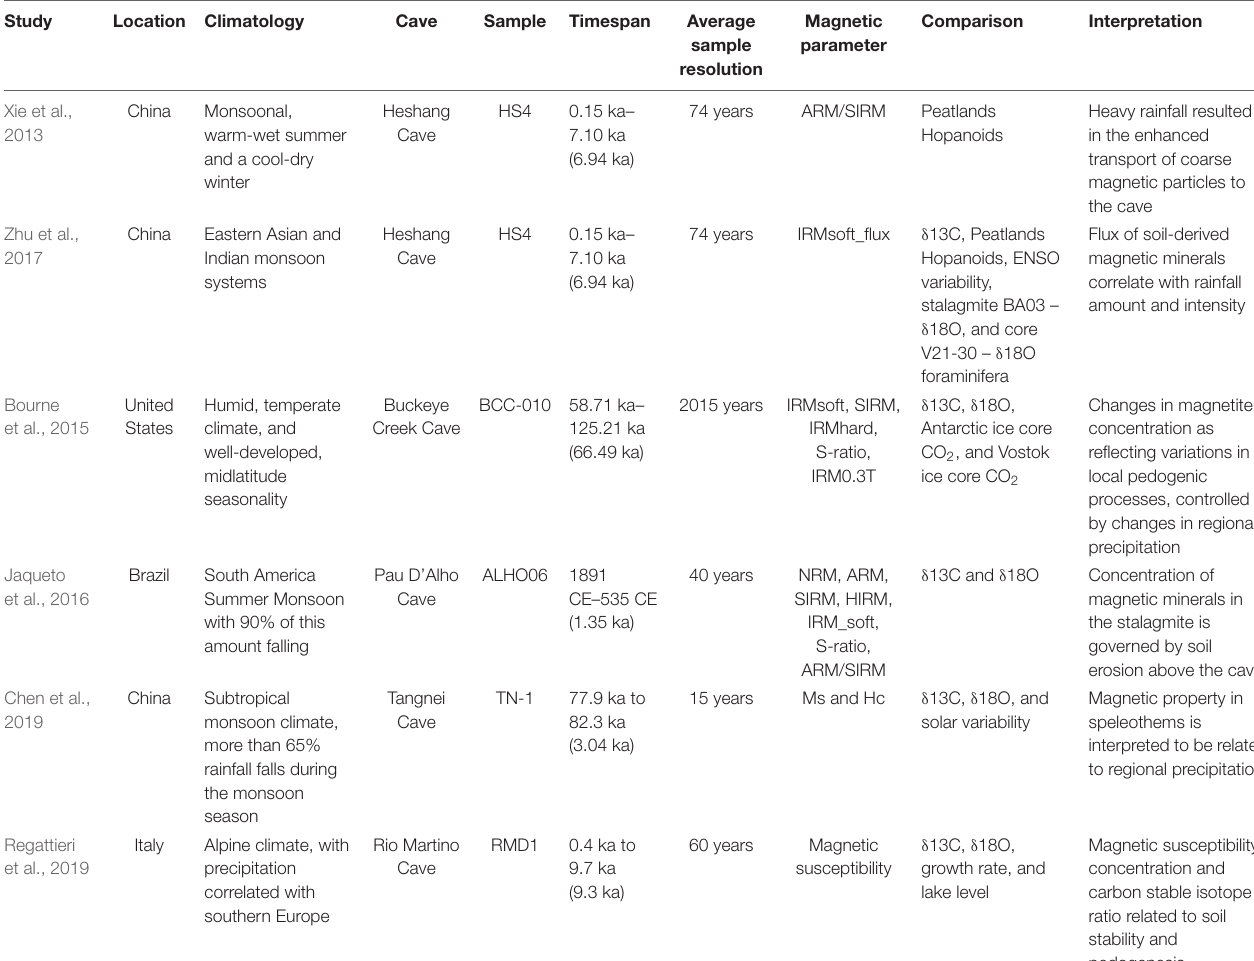
TABLE 1 | Speleothem magnetism studies and their respective resolution and interpretation.